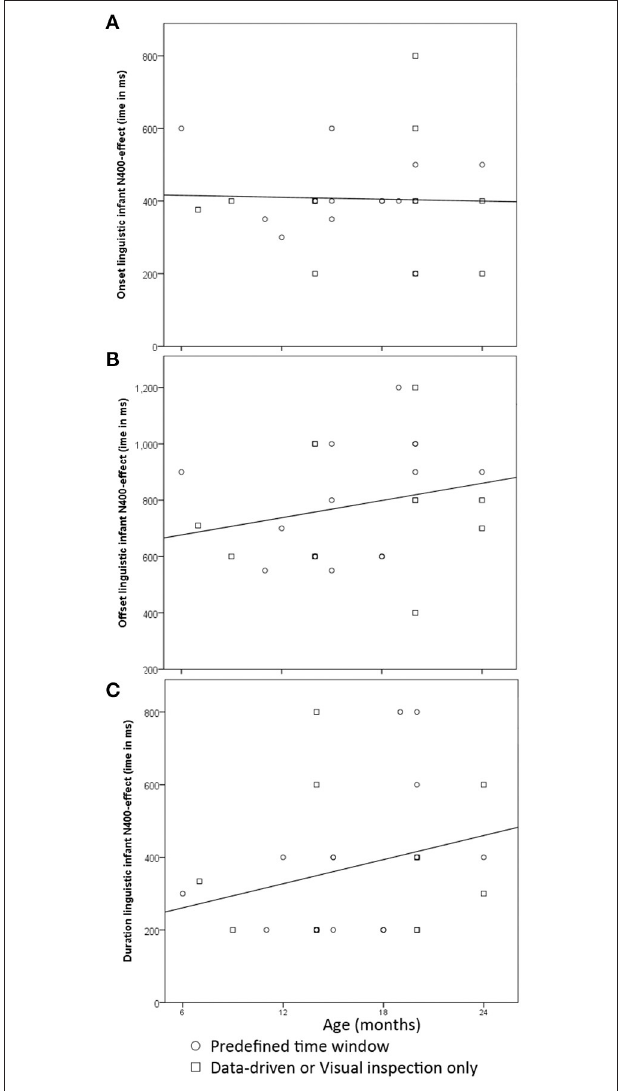
FIGURE 2 | Scatterplots with the time window for the N400 as a function of infant participants’ ages in months: (A) —onset; (B) —offset; (C) —duration of the time window all in